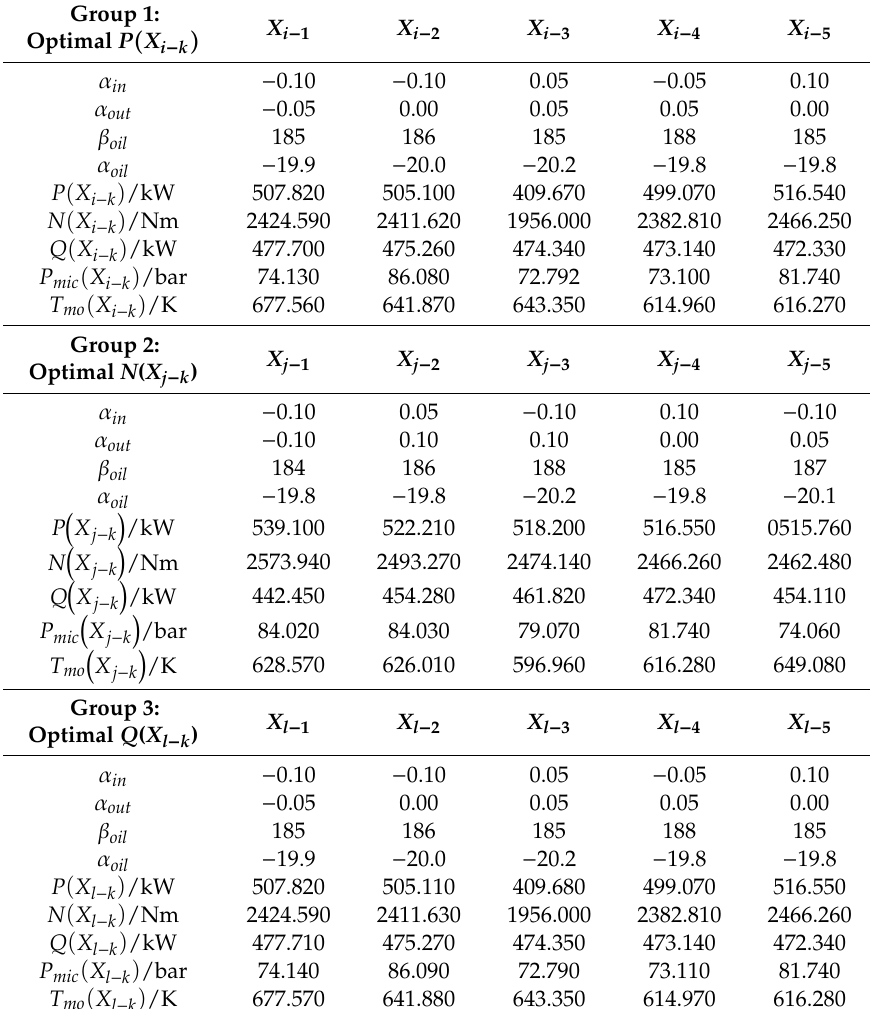
Table 10. Values and corresponding results of X.